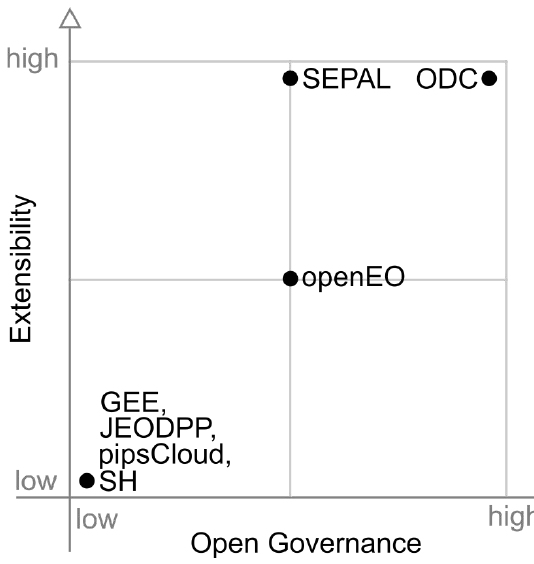
Figure 13. Open Governance vs.